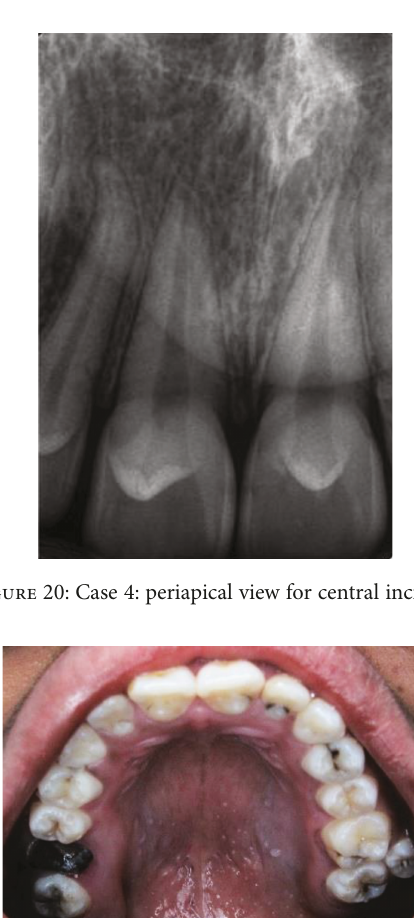
Figure 19: Case 4: dental panoramic tomography (DPT) shows taurodontism in molars.